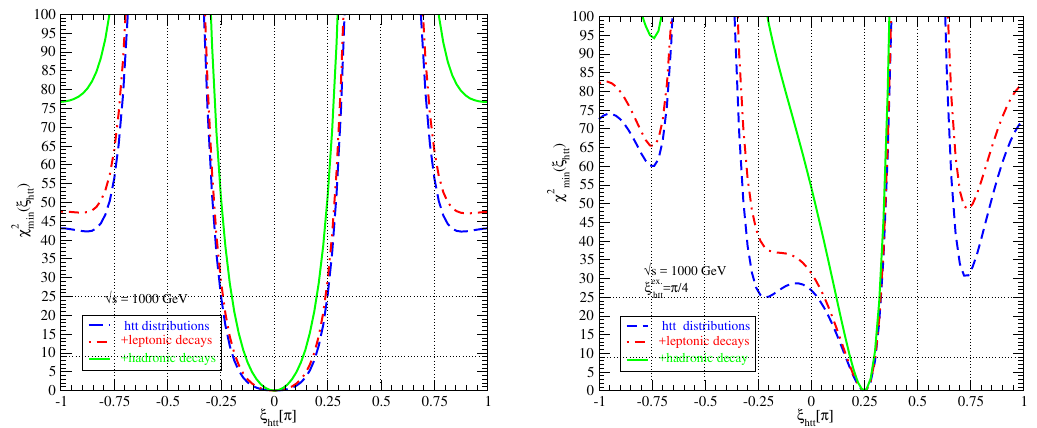
Figure 13 . The (cid:31) 2 plot at p s = 1000 GeV. (cid:31) 2 when (cid:24) ex = 0 (the SM Higgs) is assumed for the data (left panel) and when (cid:24) ex htt (right